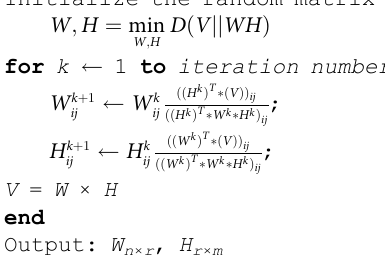
Algorithm 2 : NMF-testing process